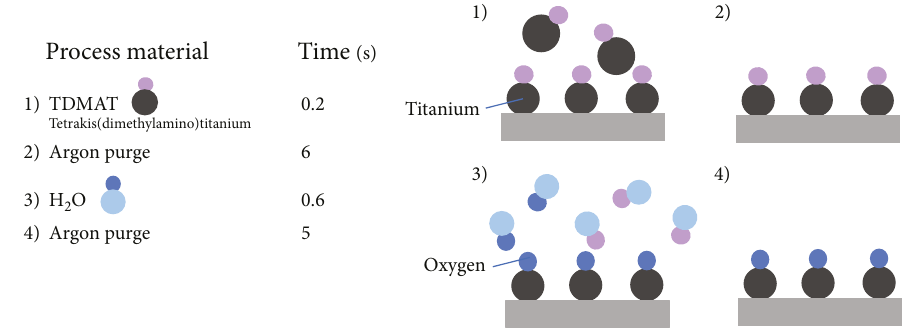
Figure 3: Process fl ow for ALD TiO and reacts with TDMAT in a self-limiting reaction; the excess H